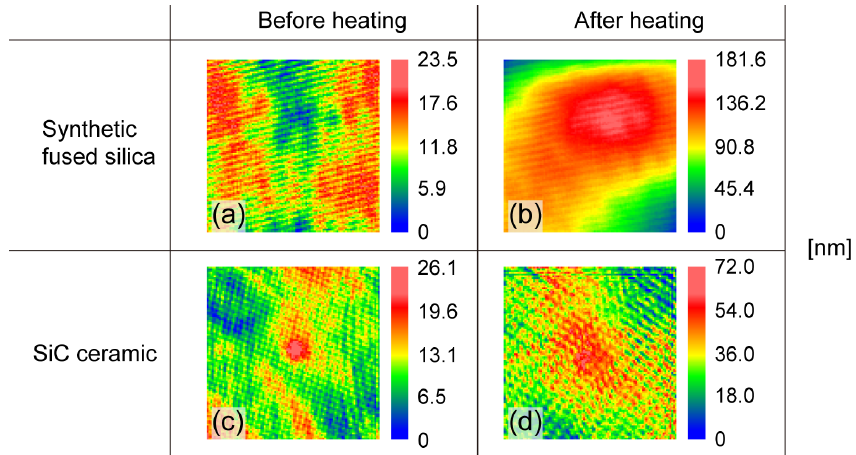
Figure 3. Surface accuracies of gold mirrors measured with a laser interferometer in a 20 × 20 mm square. The color scales are normalized to the maximum in each picture. Surface accuracies of the synthetic fused silica mirror ( a ) before laser irradiation and ( b ) after 20 min laser irradiation. Surface accuracies of the SiC ceramic mirror ( c ) before laser irradiation and ( d ) after 20 min laser irradiation. The values of peak-to-valley surface accuracy (roughness) in ( a ), ( b ), ( c ) and ( d ) are / 26.9 (23.5 nm), / 3.5 (181.6 nm), / 24.2 (26.1 nm), and / 8.8 (72.0 nm), respectively.